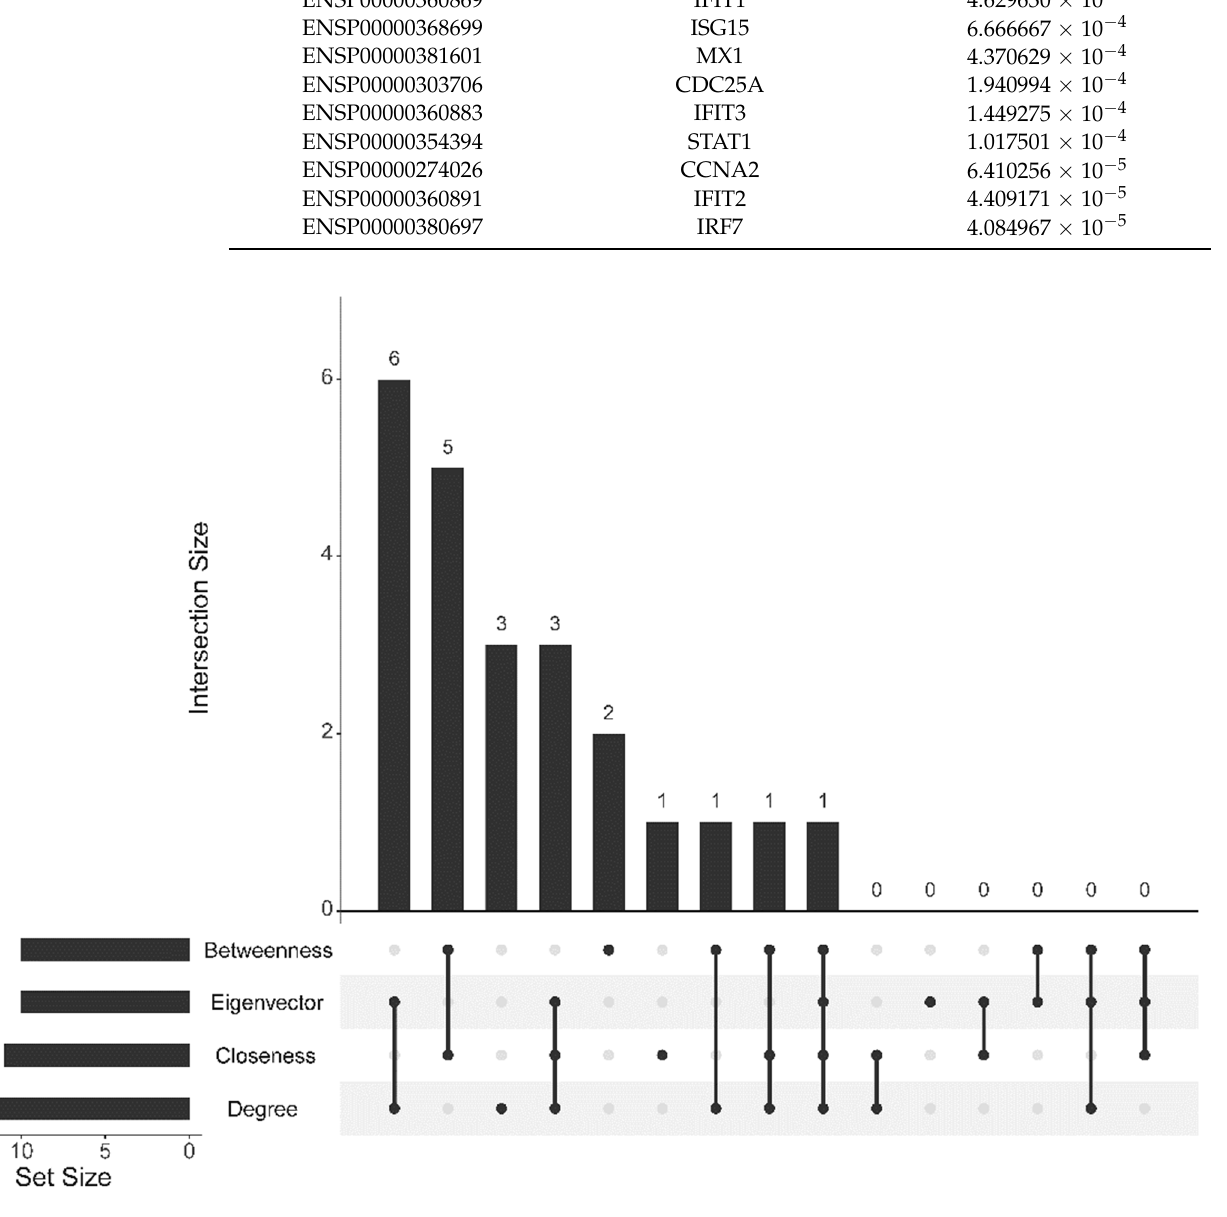
Figure 7. Upset plot of nodes with high values in the four centralities: degree, betweenness, closeness, and eigenvector centrality.